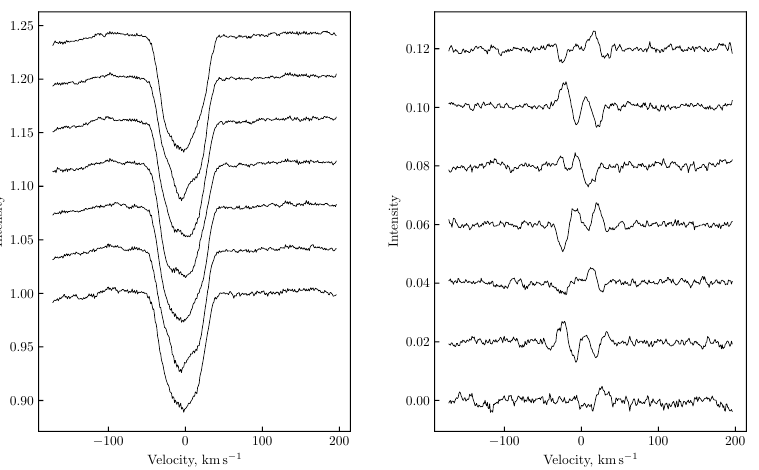
Figure 4. The pulsational least-squares deconvolution (LSD) line profile variations in AS Eri observed with the SALT telescope. ( Left panel ) Pulsational variations of LSD profiles; ( right panel ) the residual line profile